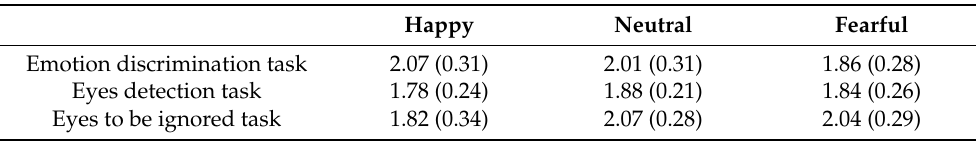
Table A1. P1 amplitudes for happy, neutral, and fearful eye regions under different tasks. Means are presented with standard error in